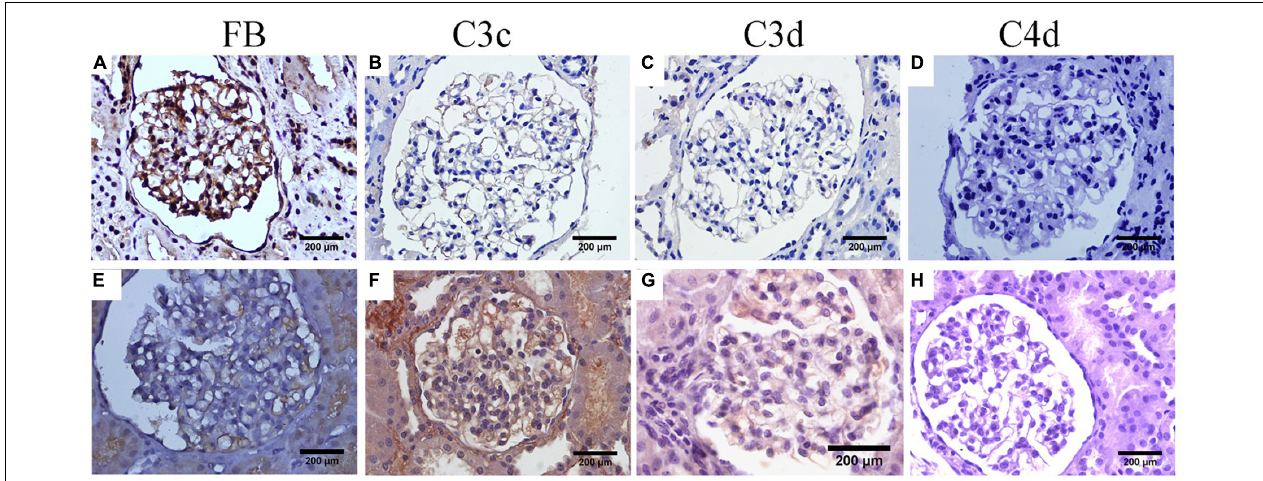
FIGURE 3 | Immunohistochemical staining of complement components. (A–D) For the proband. (E–H) For his elder sister. (A,E) FB staining within glomerular capillary and segmental mesangial for the proband and his elder sister, respectively. (B,F) C3c staining mainly along glomerular capillary for the proband and his elder sister, respectively. (C,G) Weak glomerular staining with C3d along glomerular capillary for the proband and his elder sister, respectively. (D,H) Absent glomerular C4d staining for the proband and his elder sister,